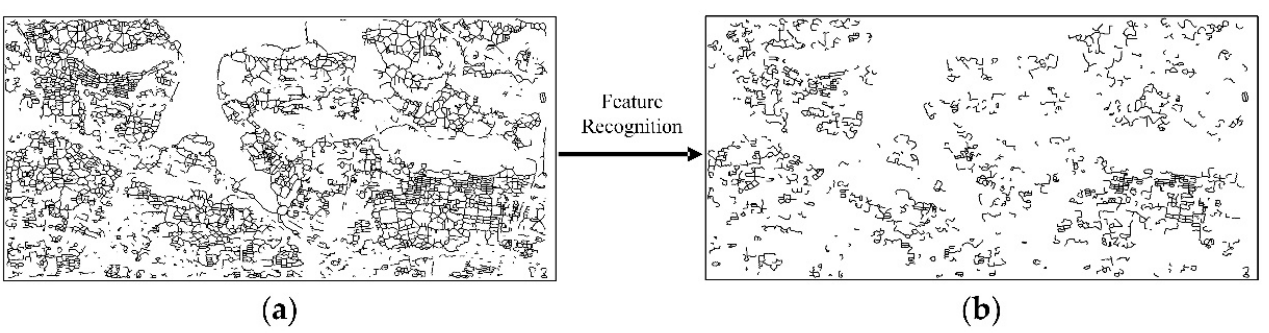
Figure 15. Experiments of feature consistency: ( a ) skeleton lines overlay with OSM (the red part is OSM roads, and the black one is the skeleton); ( b ) retained skeleton lines.